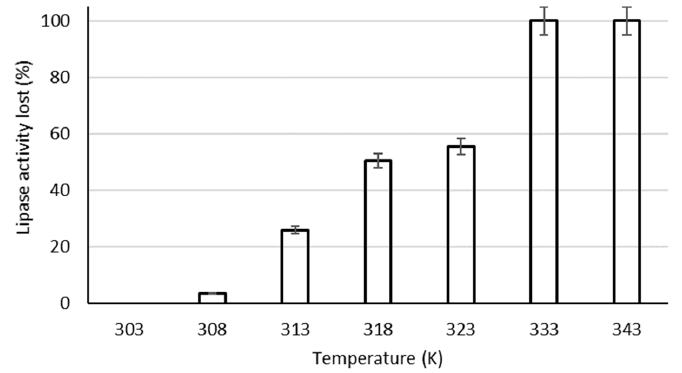
Figure 6. Endogenous lipase activity lost after the treatment at different temperatures (K) for 60 min.